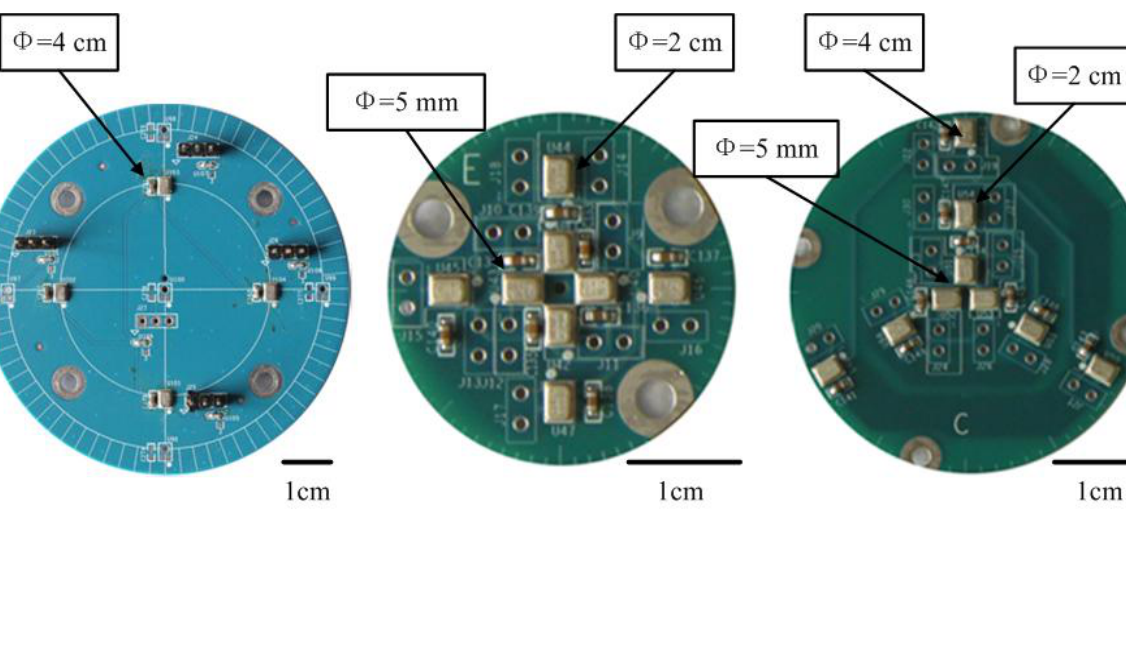
Figure 1. Microphone arrays designed for verification of accuracy of direction